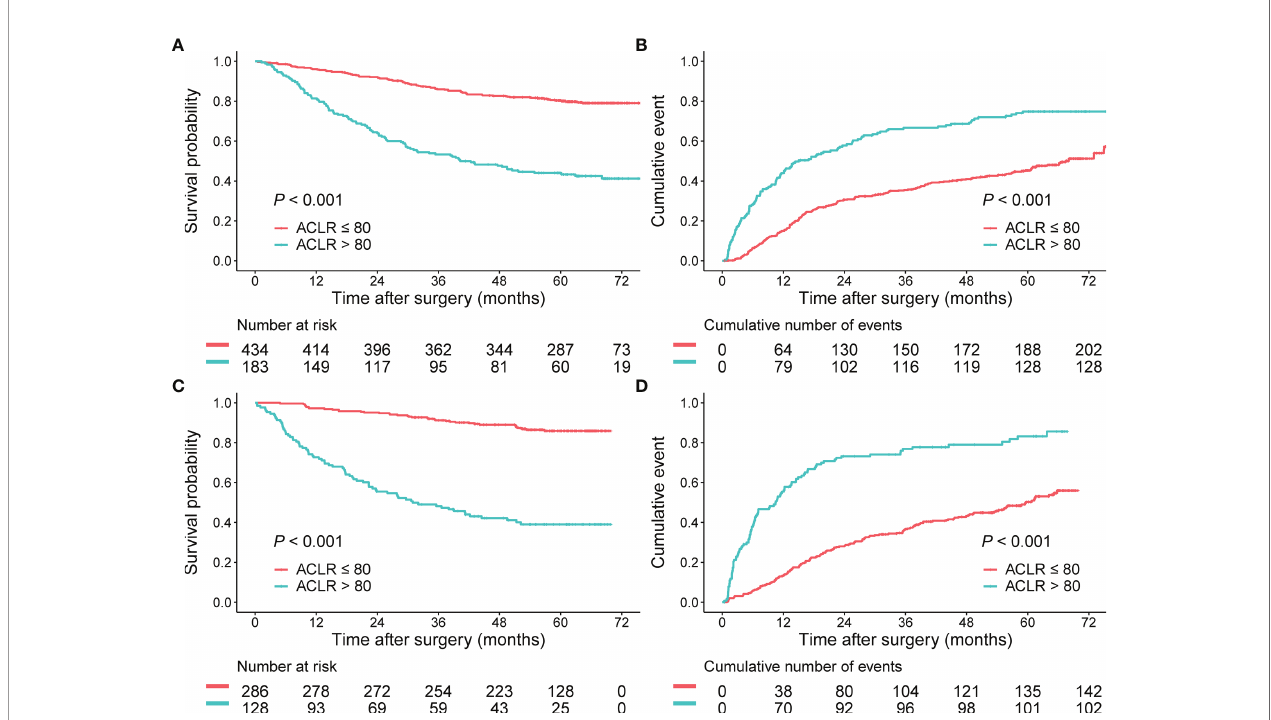
FIGURE 2 | Prognostic performance of ACLR in patients with HCC from the training cohort and validation cohort. (A, B) Kaplan – Meier analysis of OS (A) and recurrence rates (B) for patients with HCC strati fi ed by ACLR (cutoff = 80) from the training cohort. (C, D) Kaplan – Meier analysis of OS (C) and recurrence rates (D) for patients with HCC strati fi ed by ACLR (cutoff = 80) from the validation